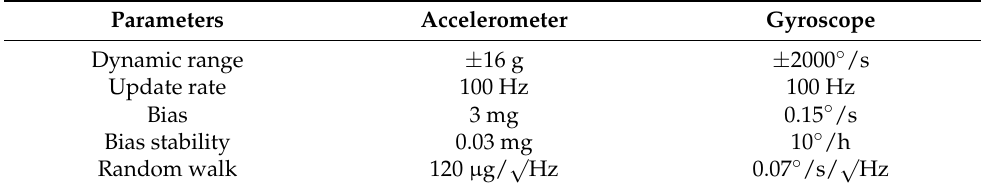
Table 1. Specifications of MTI-1.